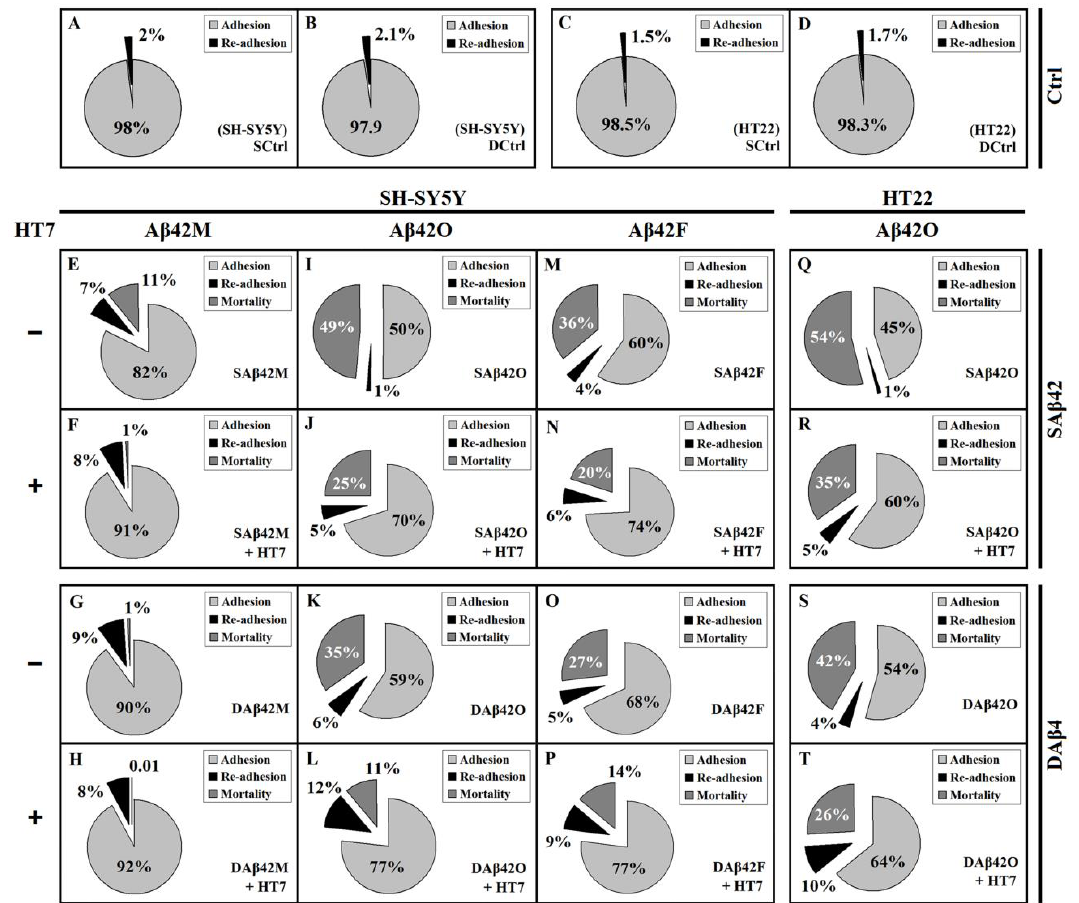
Figure 2. Relative adhesion, re-adhesion, and mortality rates of SH-SY5Y and HT22 cells in the presence of various extracellular SA β 42 and DA β 42 species with/without anti-oligomeric A β 42 scFv HT7 (or HT6) for 12 h. The relative adhesion rates were from the data of Figure 1. The relative re-adhesion rates were determined by MTT assay after between 4 and 6 h of re-culture of the shed cells in normal 10% DMEM medium at 37 ◦ C and calculated based on 100% of the relative total cell viability in the Ctrl0 group (without aspirating shed cells). The relative mortality rate was calculated by the difference between 100% and the sum of the relative adhesion and re-adhesion rates. The relative mortality rate of the Ctrl group was too small and was ignored. ( A – D ): SCtrl and DCtrl of SH-SY5Y and HT22 cells, corresponding to a in Figure 1. ( E – H ): corresponding to d and g in Figure 1A,B. ( I – L ): corresponding to k and n in Figure 1A,B. ( M – P ): corresponding to r and u in Figure 1A,B. ( Q – T ): corresponding to d and g in Figure